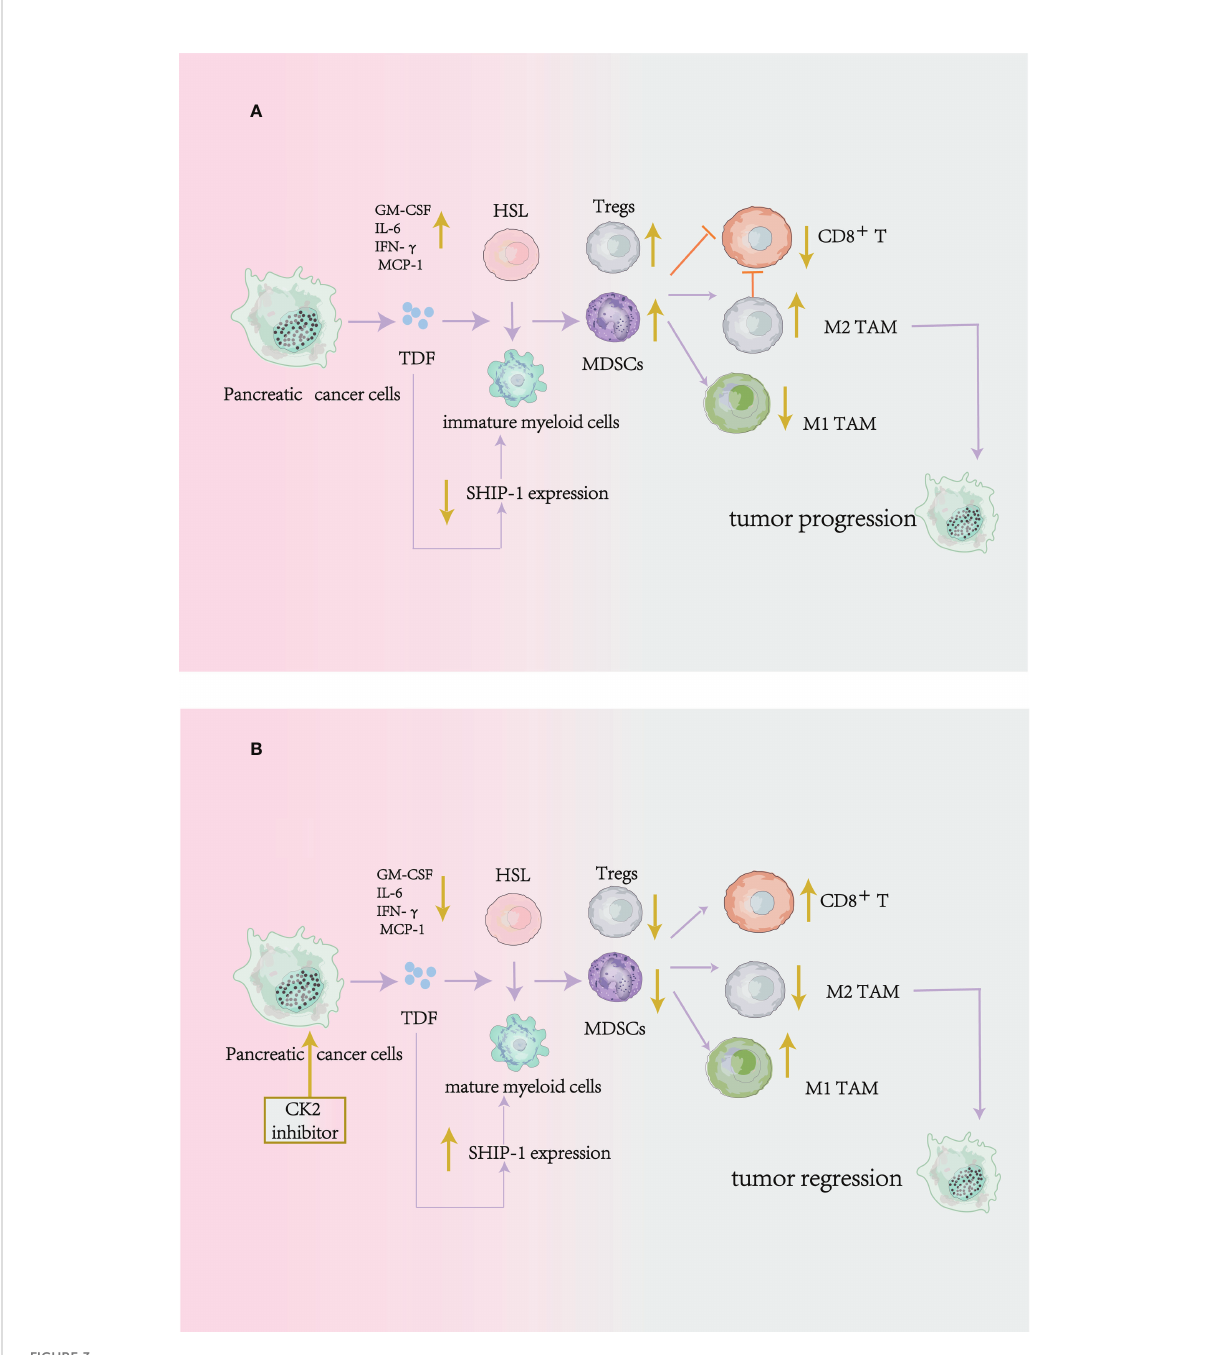
FIGURE 3 CK2 can regulate the production of tumor-derived cytokines to modulate antitumor immune responses in mouse pancreatic cancer cells. (A) without Apigenin (API: a CK2 inhibitor): Pancreatic cancer cells release tumor-derived factors (TDF), leading to a reduction of SHIP-1 expression, which causes hematopoietic stem cells (HSC) to become immature myeloid cells. The result is that the expansion of MDSCs, Tregs, and M2 phenotype TAM (pro- tumor) in the TME, on the contrary, the reduction of effector CD8 +T cells to inhibit antitumor immunity. (B) with Apigenin: apigenin can suppress the production of tumor-derived factors (TDF) produced by pancreatic cancer cells and enhance the SHIP-1 expression to reduce MDSCs and Tregs expansion, induce TAM to an M1 phenotype(antitumor) and increase the function of CD8+T cells in the TME to enhance antitumor